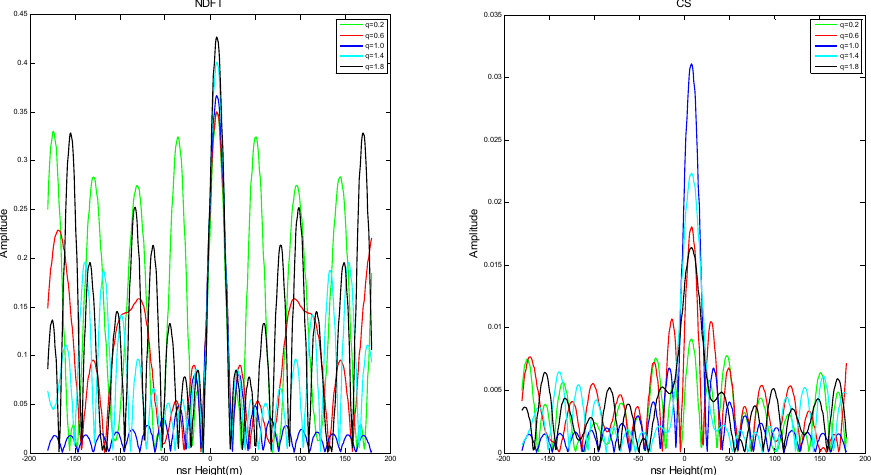
dotted line in the figure only represents the imaging result when the baseline is uniformly